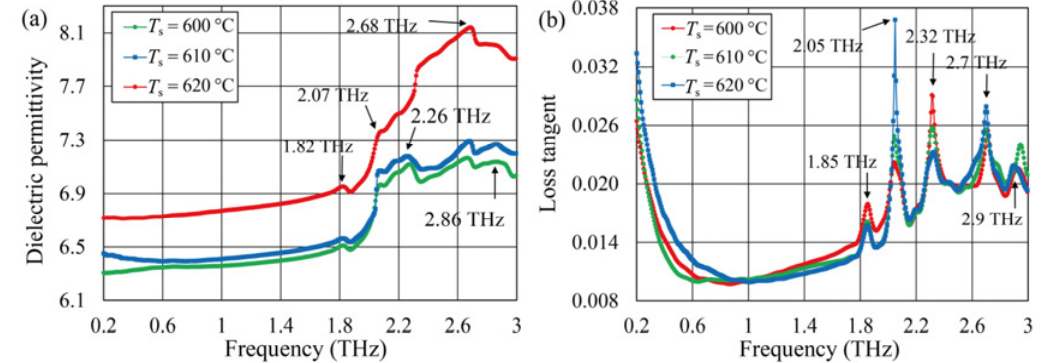
Fig. 11 Dielectric permittivity (a) and loss tangent (b) versus frequency in the range 0.2–3 THz at 20 ℃ for Li 2 WO 4 ceramics doped with 4% AlF 3 –CaB 4 O 7 , sintered at 600, 610, and 620 ℃ .